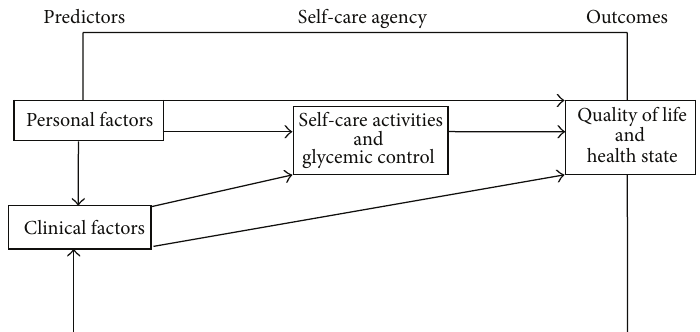
Figure 1: Health related quality of life among adults with type 2 diabetes (adapted from Sousa et al.